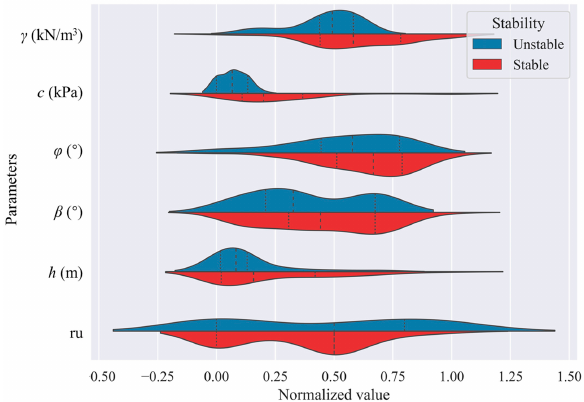
Figure 1. Violin comparison diagram of the standardized data.